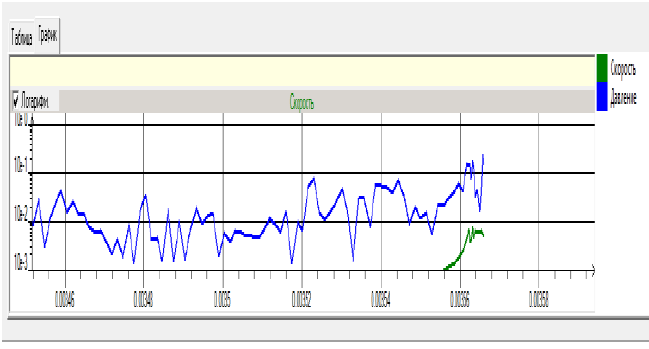
Fig. 5. Graph of velocity and pressure under leakage of jet on the walls of the calibration tube